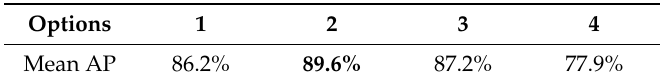
Table 3. The Mean AP values of the four different options.